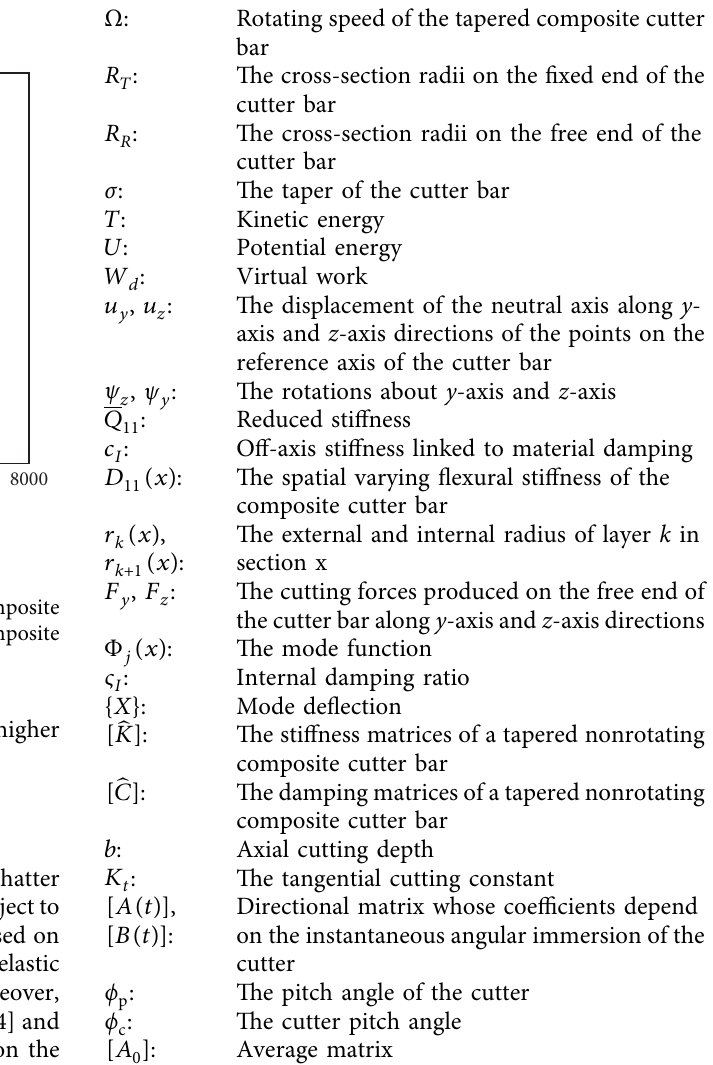
Figure 10: Effect of stacking sequence of the composite boring bar on the stability lobes.